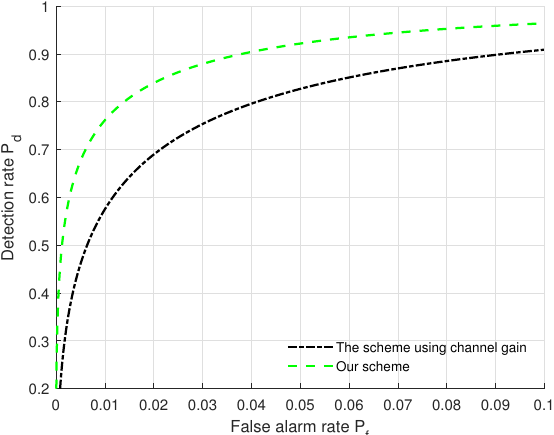
Figure 6. Performance comparison between the scheme in [16] and our scheme with the settings of (SNR = 5 dB, N r = 128, L = 20, k φ = 2 dB, k θ = 2 dB, k α = 2 dB).